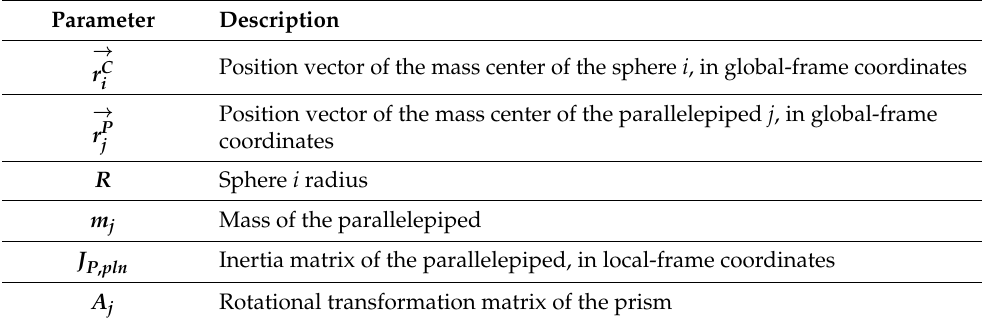
Table 4. Parameters required to calculate the indentation between a sphere and a regular